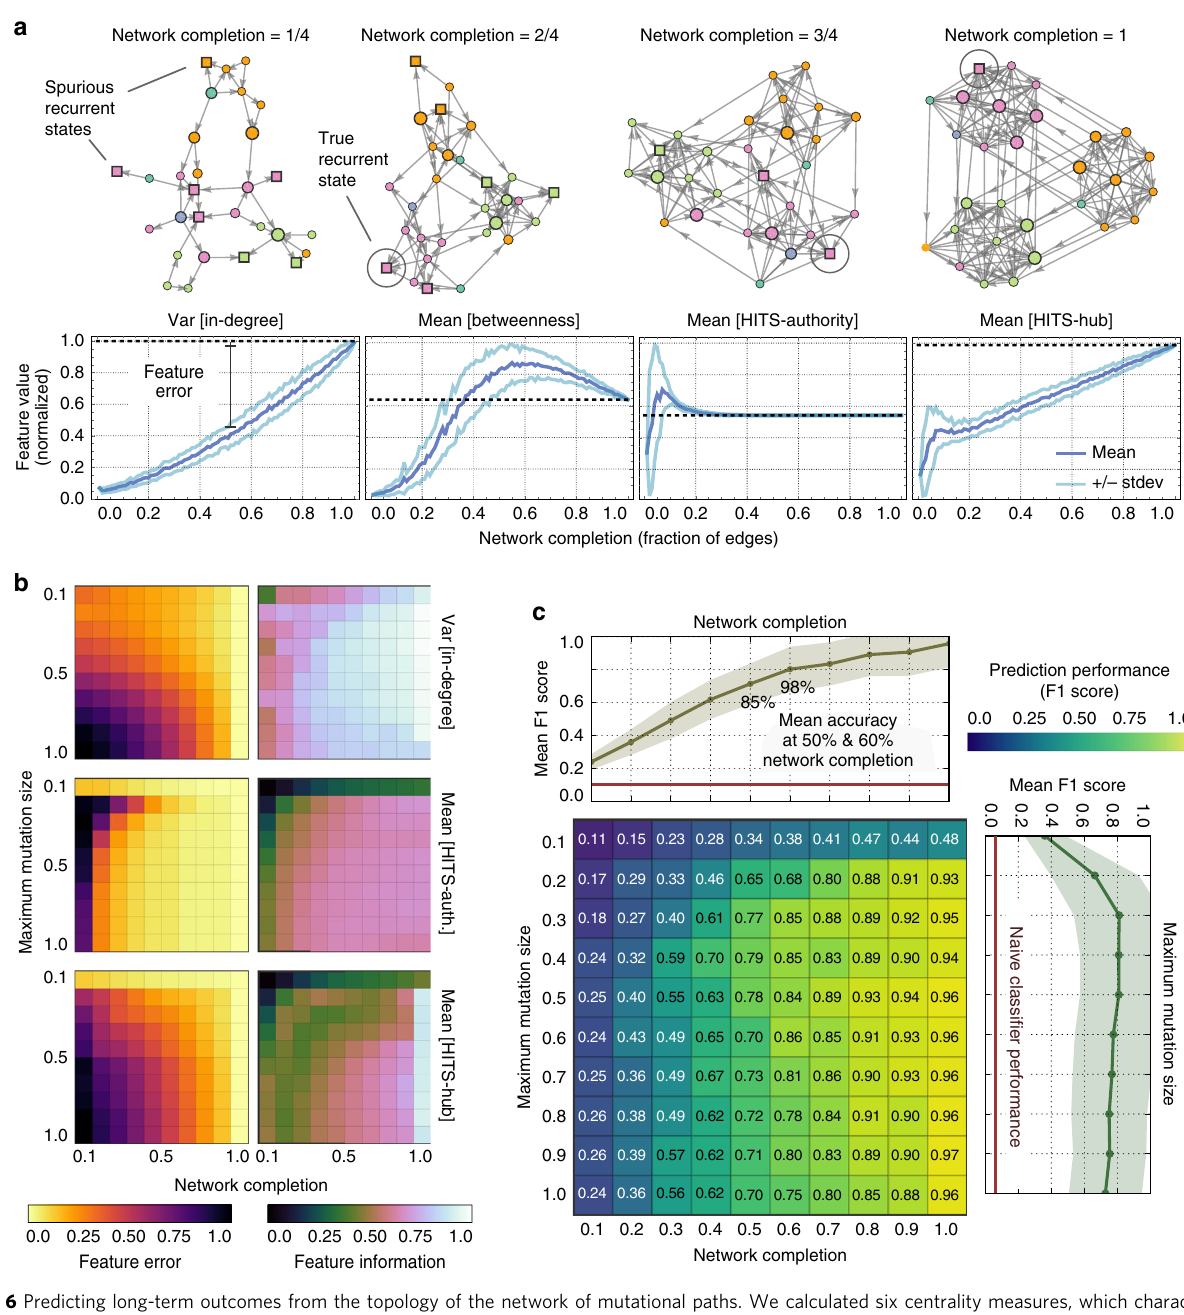
Fig. 6 Predicting long-term outcomes from the topology of the network of mutational paths. We calculated six centrality measures, which characterize different aspects of the networks ’ topology, and used these as learning features in a predictive model trained on complete and incomplete networks. a The state of a network ’ s completion affects its topology, which is re fl ected in the statistics of its centralities. As an example, we show a network in various states of completion and the corresponding progression of four statistics ( dark blue shows the mean and light blue shows the s.d. calculated for 100 different networks). b We characterized the statistics of the centralities by how they converge to their value when the network is complete (the feature error) and by how well they can discriminate between evolutionary outcomes (mutual information). The plots show the mean of the feature error and the mean of the mutual information between the statistic and the evolutionary outcomes. c Evolutionary outcomes predicted with a classi fi er trained on the statistics of the centralities from partial and complete networks. We assessed performance via the unweighted mean of the F 1 score taken over the seven outcomes. The mean test-set performance is reported for 10-fold cross-validation. Top and right line plots show the mean performance, with the s.d.s as shaded regions , taken over either the state of completion of the network or the maximum size of mutation. The red line is the performance of a naive classi fi er, which predicts following the empirical frequencies of the